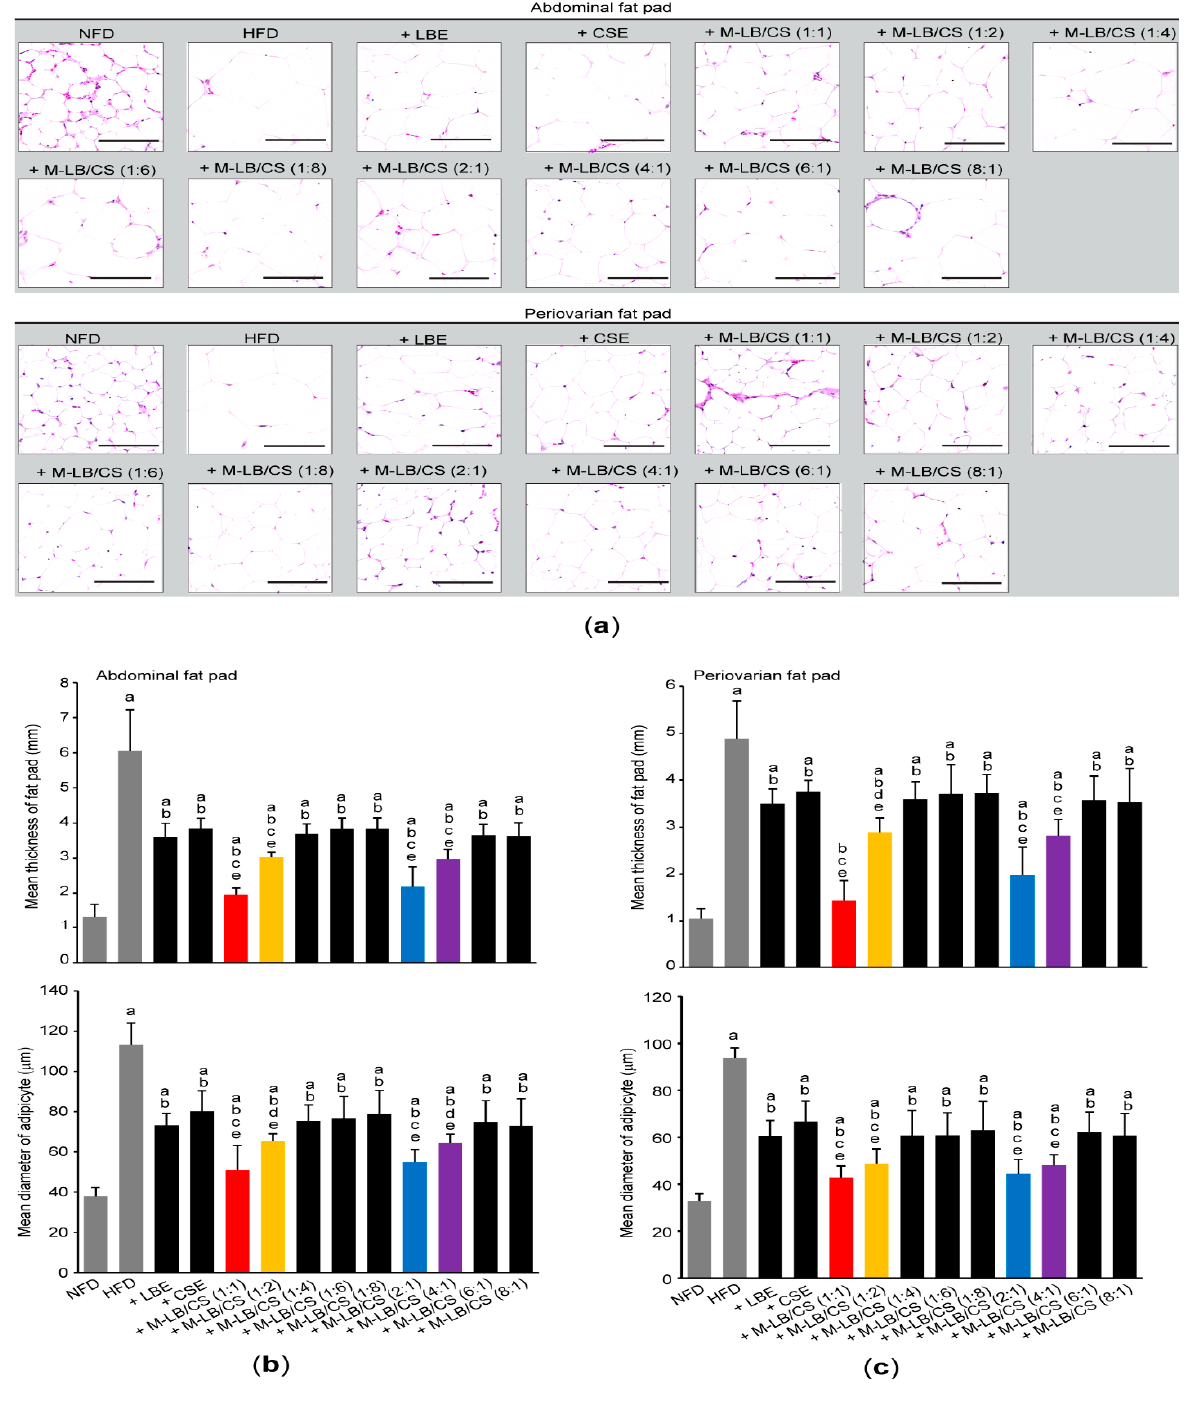
Figure 4. M-LB/CS reduces the hypertrophy of adipose tissue. Abdominal and periovarian fat pads were stained with hematoxylin and eosin ( a ). Thickness of fat fad ( upper ) and mean diameter of adipocytes ( lower ) from abdominal ( b ) and periovarian ( c ) fat pad were calculated using an image analyzer. a p < 0.01, vs. NFD; b p < 0.01, vs. HFD; c p < 0.01, d p < 0.05, vs. HFD + LBE; e p < 0.01, vs. HFD + CSE.